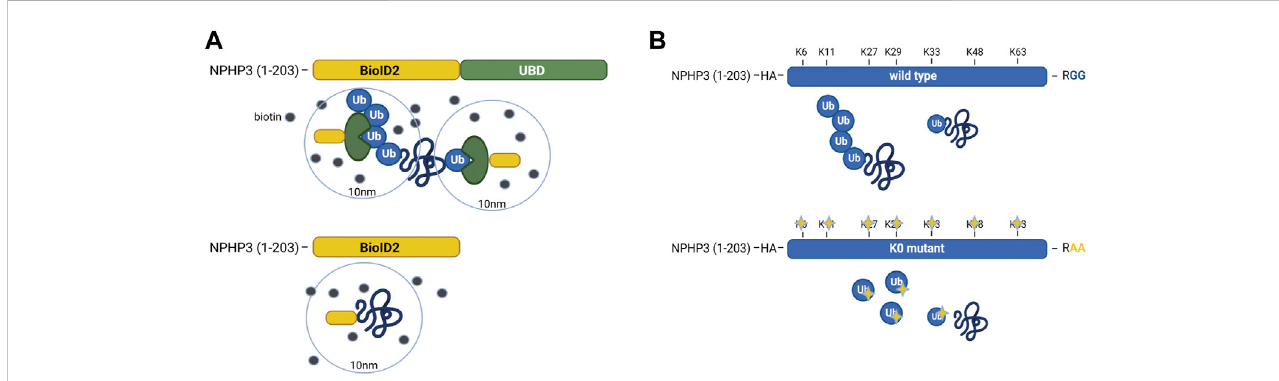
FIGURE 1 SchematicrepresentationoftheUBD-PLandUAPproteomicsapproaches (A) InIMCD3cells,theUbiquitin-bindingdomainProximityLabeling(UBD-PL) approach was developed. Using the NPHP3 targeting strategy, the C-terminal ubiquitin-binding domain (UBD) of the RAD23b protein was fused to the BioID2 proximity labeling tag. The RAD23b protein contains a tandem of two UBAs at its C terminus, which were utilized in this study as an indirect bait for polyubiquitinated substrates. These polyubiquitinated targets will become biotinylated when they come into proximity with the BioID2 tag, which promiscuously attaches biotin moieties to primary amines within an estimated radius of 10 nm. As a control, an NPHP3 (1-203)-targeted BioID2 recombinant protein was used. (B) For the Ubiquitin Af fi nity Proteomics (UAP) approach in RPE1 cells, the NPHP3 ciliary targeting sequence was fused to either wild type (WT) ubiquitin, or a lysine-less ubiquitination-impairedK0 ubiquitinmutant which is unable to bind substates, as the C-terminal Gly residues were mutatedto Ala. To facilitate af fi nity puri fi cation and visualization in cells, the hemagglutinin (HA) tag was included at the N-terminus of ubiquitin in both